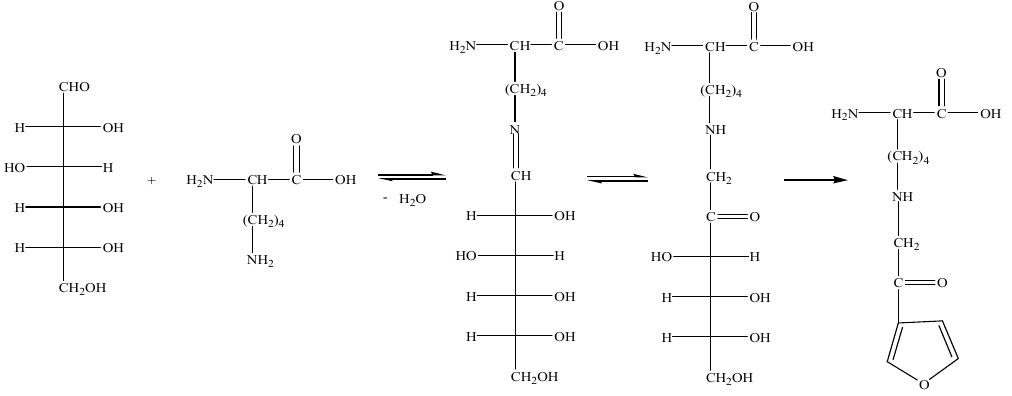
Figure 1. Reaction pathway for conversion of glucose and lysine into furosine via the Maillard reaction.